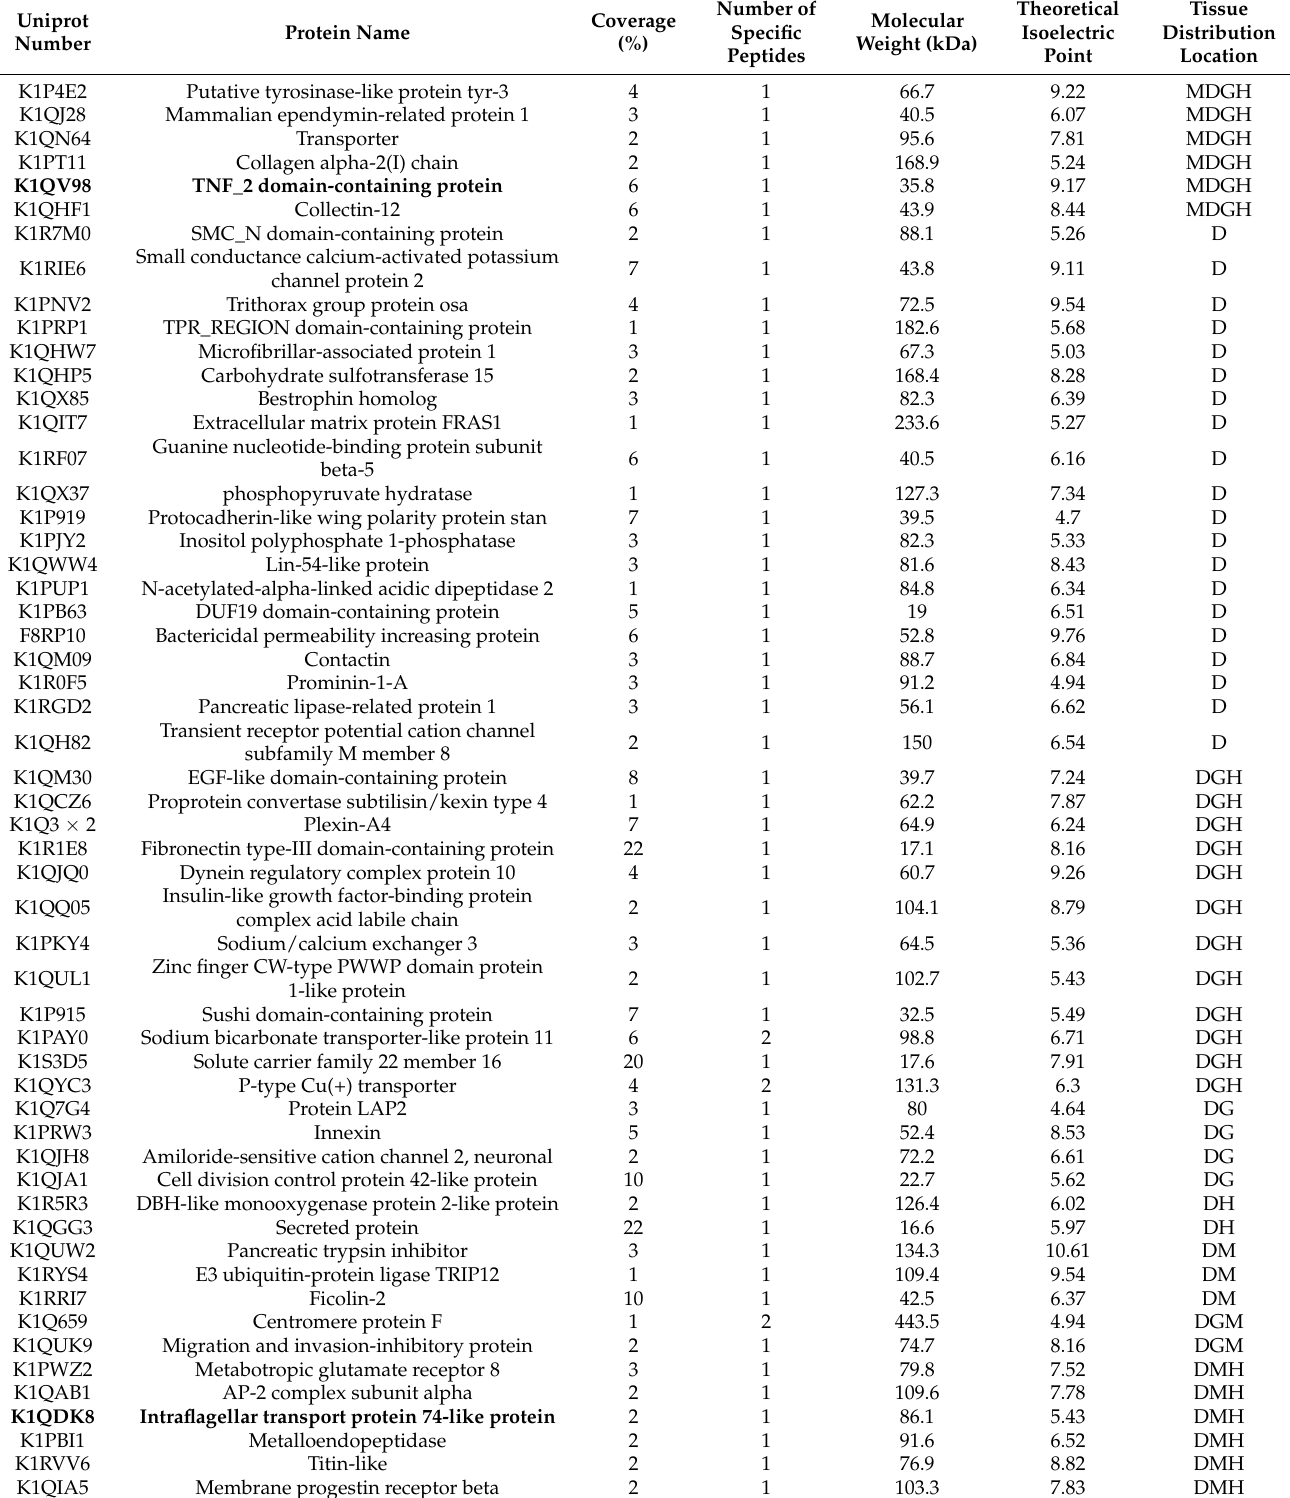
Table 1. Details of the 55 potential proteinaceous ligands of GI.1